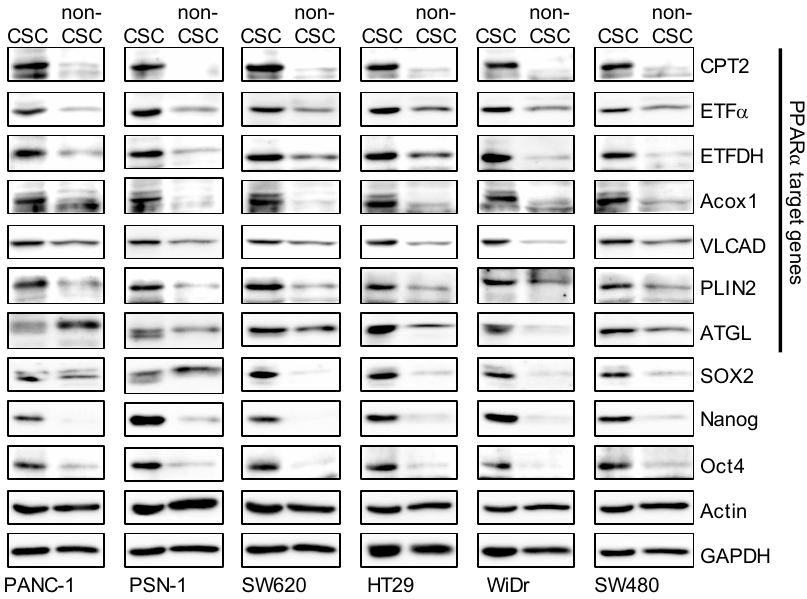
Figure 2. The expression levels of peroxisome proliferator-activated receptor α (PPAR α ) target genes in cancer stem cells (CSCs) were higher than in non-cancer stem cells (non-CSCs). Pancreatic-cancer- derived (PANC-1, PSN-1) and colorectal-cancer-derived (SW620, HT29, WiDr, and SW480) CSCs and non-CSCs were subjected to immunoblot analyses of the indicated proteins. Similar results were obtained from two independent biological